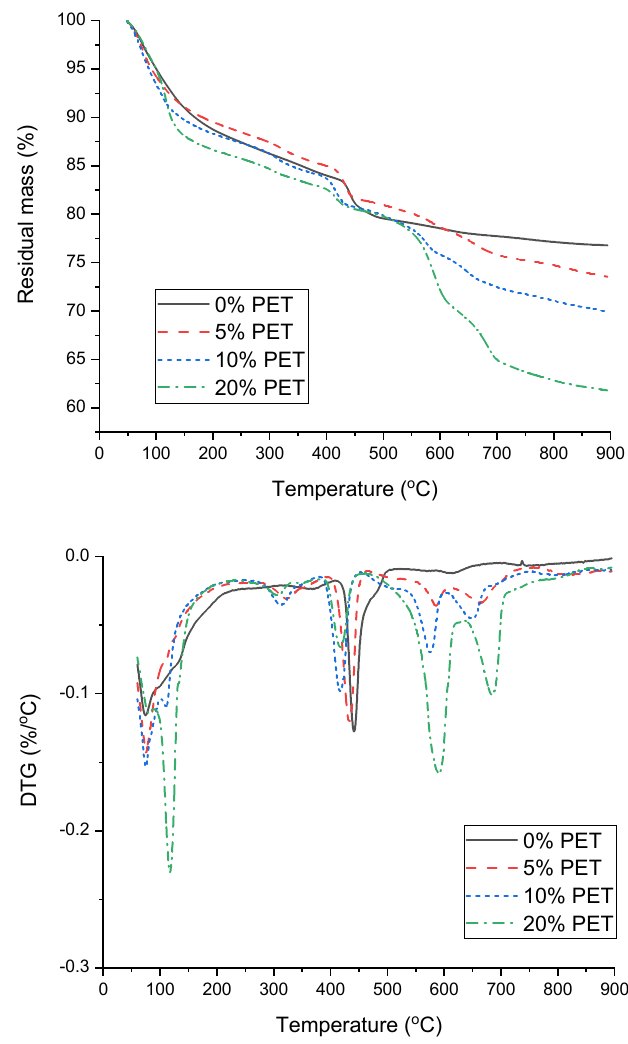
Figure 8. DTG curves of cement paste samples incorporating PET powder.